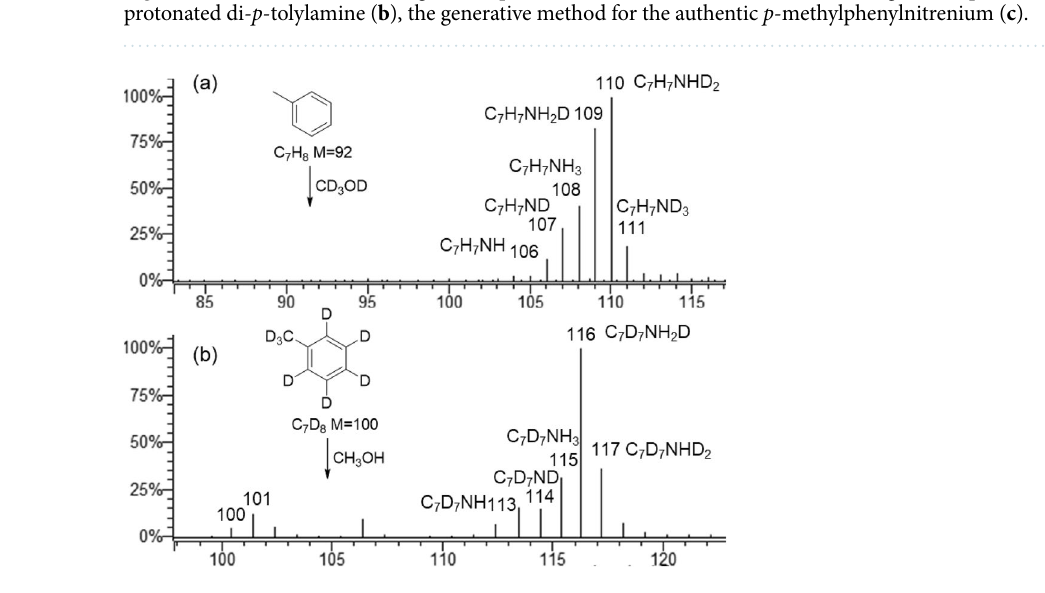
Figure 3. Full-scan APCI mass spectra of toluene/CD 3 OD ( a ) and d 8 -toluene/CH 3 OH ( b